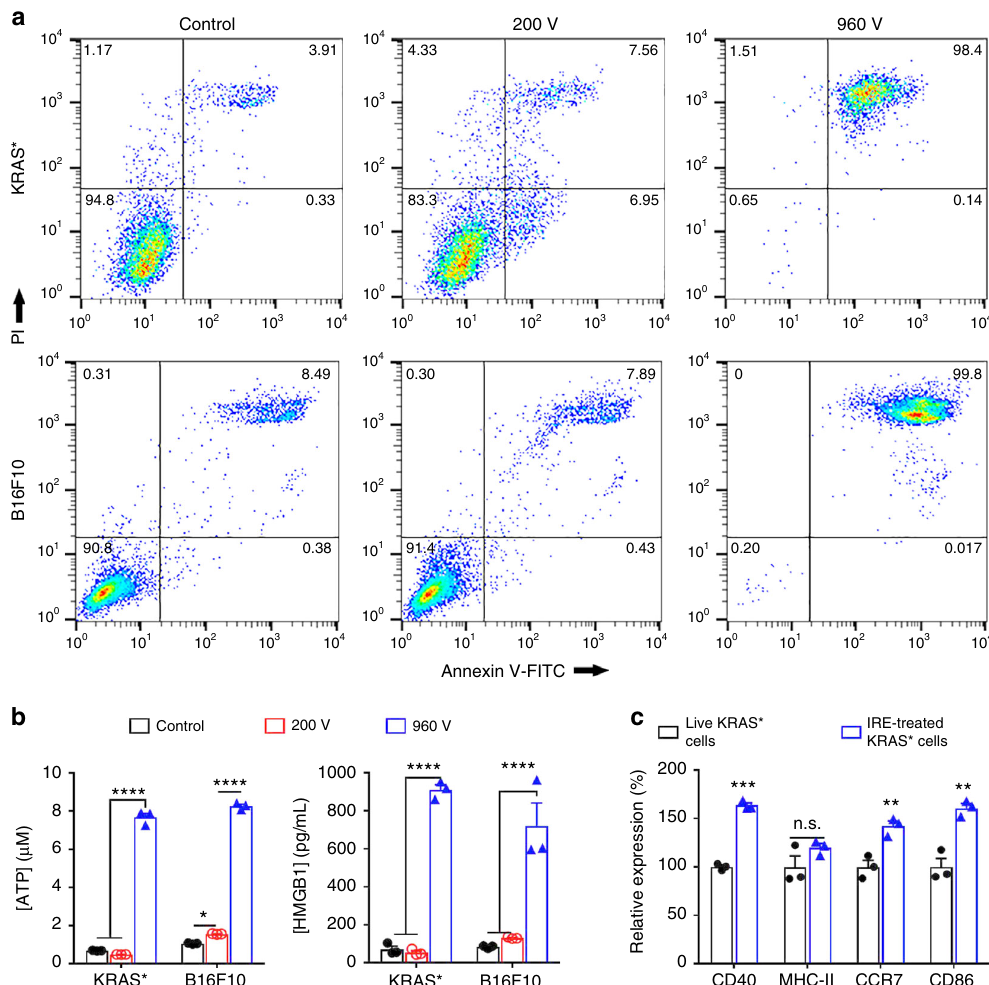
Fig. 5 In vitro analyses of IRE-treated cancer cells and their impacts on dendritic cells. a Annexin V-FITC / PI staining of KRAS* and B16F10 cells. Cells were suspended in phosphate buffered saline (PBS) and electroporated in a cuvette with a 4-mm gap. The parameters for electroporation were: voltage = 200 or 960 V, pulse duration = 100 µ s, pulse repetition frequency = 1 Hz, number of pulses = 20. Cells were stained and analyzed within 30 min of treatment. b ATP and HMGB1 concentrations in cell supernatants of untreated control (black square), 200 V (red square), and 960 V (blue square) groups ( n = 3). c Relative expression of DC activation markers, including CD40, MHC-II, CCR7, and CD86, on bone marrow-derived DCs (CD11c + ) after incubation with live or IRE (960 V)-treated KRAS* cells for 24 h. Expression was quanti fi ed via geometry mean fl uorescence intensity (MFI; n = 3). Data are representative of 3 independent experiments and presented as mean ± standard error of mean (SEM). Signi fi cance was determined using two-sided Student ’ s t -test. **** p < 0.0001, n.s. not signi fi cant. Source data are provided as a Source Data fi